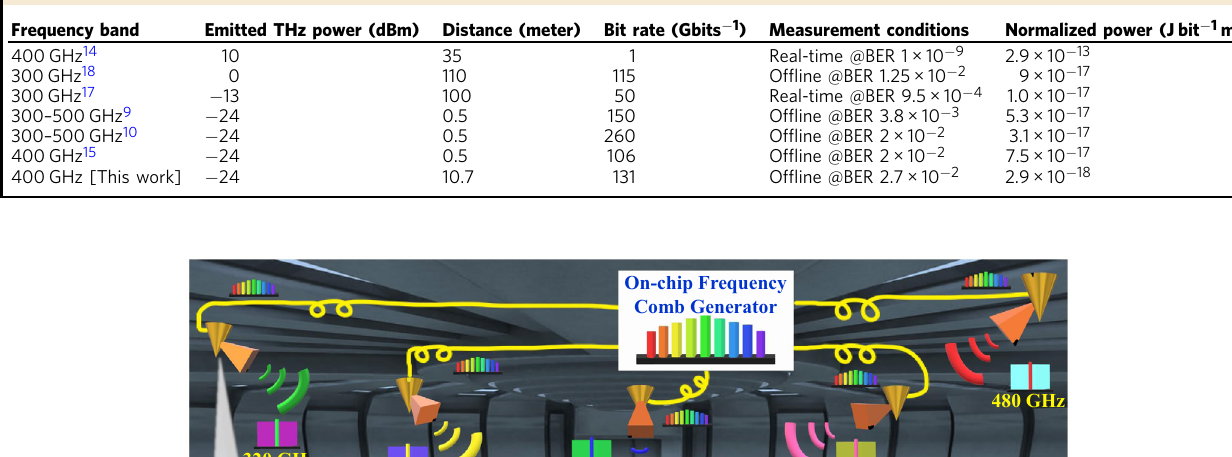
Table 1 Comparison of selected representative THz transmission demonstrations above 300 GHz in terms of normalized transmitter THz energy.